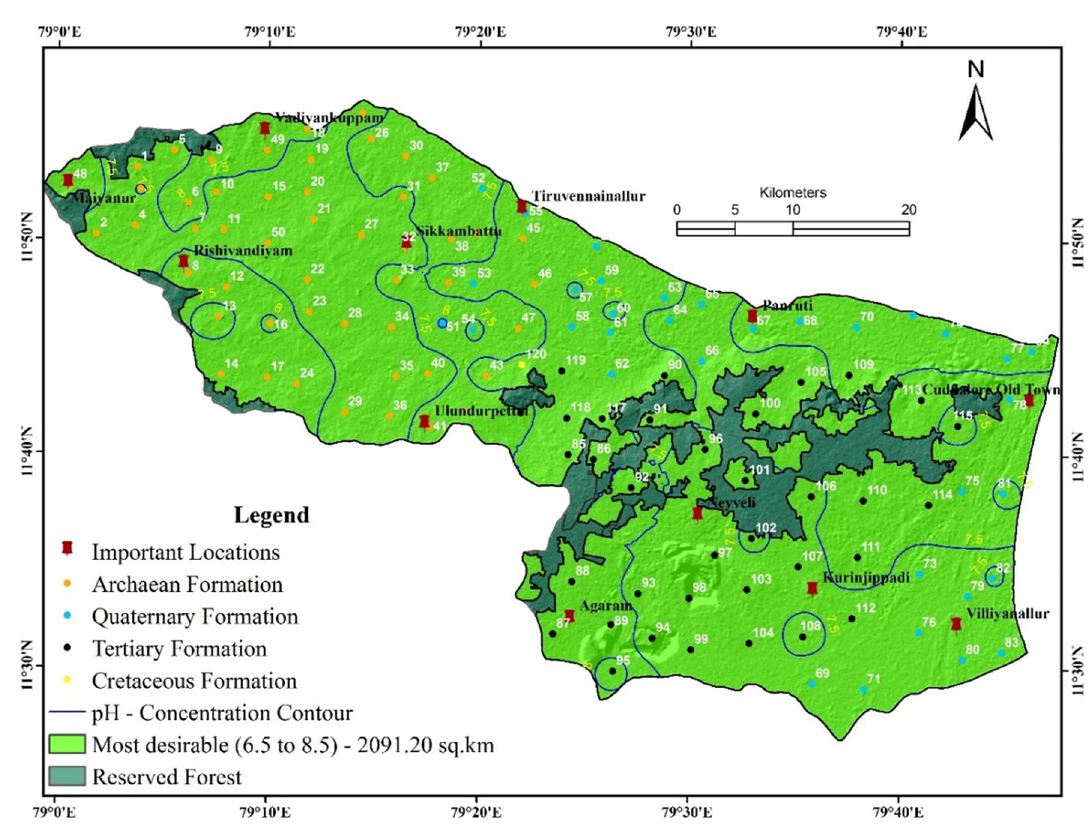
Fig. 3 Groundwater quality